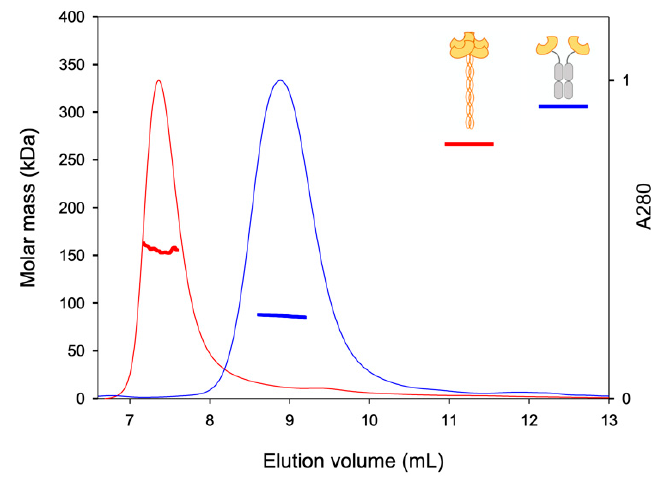
Figure 4. SEC-LS analysis of ECD construct (red) and Fc-CRD construct (blue). Normalized chromatograms at 280 nm (thin lines), and molar mass (thick lines) along the elution profiles. Molar masses were determined by combining refractive index and light scattering.